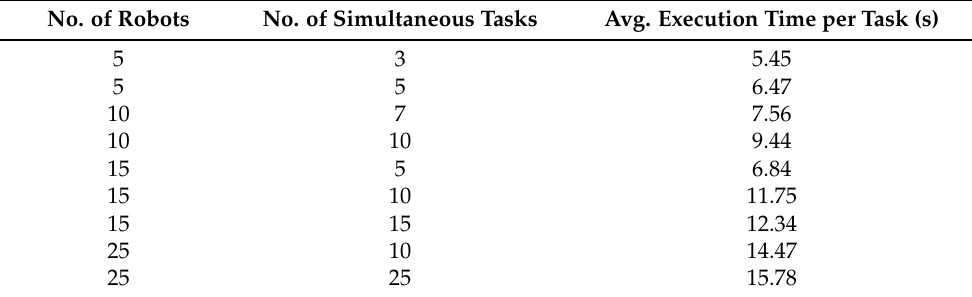
Table 1. Simulation results for a 100 × 100 warehouse